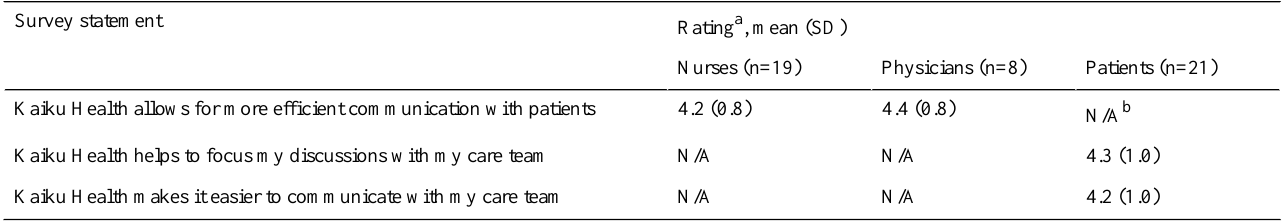
Table 2. Effect of the digital patient monitoring and management tool on patient–health care professional communication for end-of-study survey